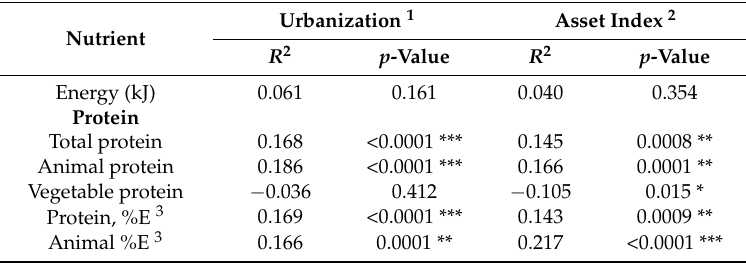
Table 5. Pearson correlations of nutrients with urbanization duration and the asset